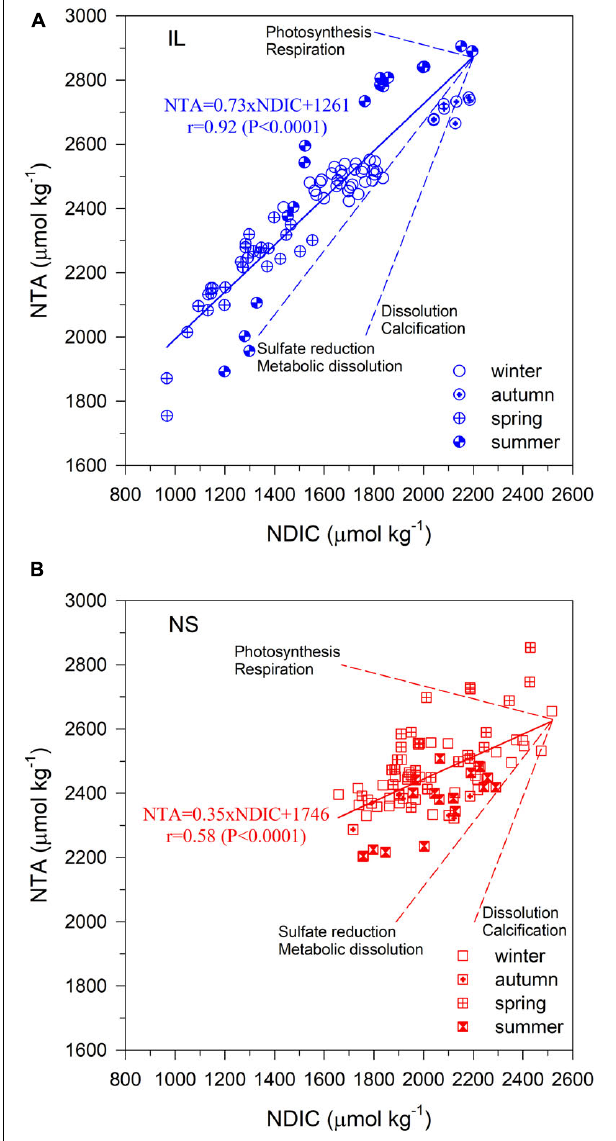
FIGURE 6 | Covariation in NTA and NDIC for the water samples collected in (A) the inner lagoon (IL), and on (B) the northern shore (NS) of Dongsha Island. The solid lines represent the regression lines. The dotted lines represent the stoichiometric ratios of major biogeochemical processes: photosynthesis/respiration, calcification/dissolution, metabolic dissolution, and sulfate